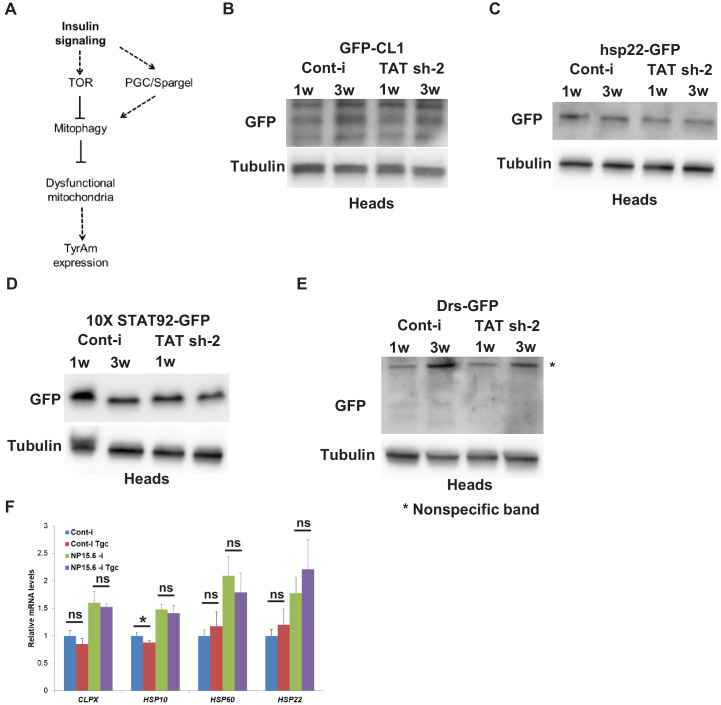
The effect of downregulation of tyrosine aminotransferase/TAT on GFP-tagged reporters relevant to aging.(A) Schematic diagram of mitophagy/mitochondrial biogenesis regulation by Insulin signaling, TOR, and PGC1a/Spargel. (B) Immunoblot analysis of GFP and tubulin in heads of 1-week and 3-week-old tubulin-Gal80ts, elav-Gal4 flies in the presence of GFP-CL1 (B), hsp22-GFP (C), 10XSTAT92-GFP (D), Drs-GFP (E) reporters expressing either control or TAT RNAi. (F) Relative mRNA levels of CLPX, HSP10, HSP60, and HSP22 in tubulin-Gal80ts, tubulin-Gal4 flies expressing either control RNAi or NP15.6 RNAi and fed with either control or 100 µM Tigecycline. Means ± SD.